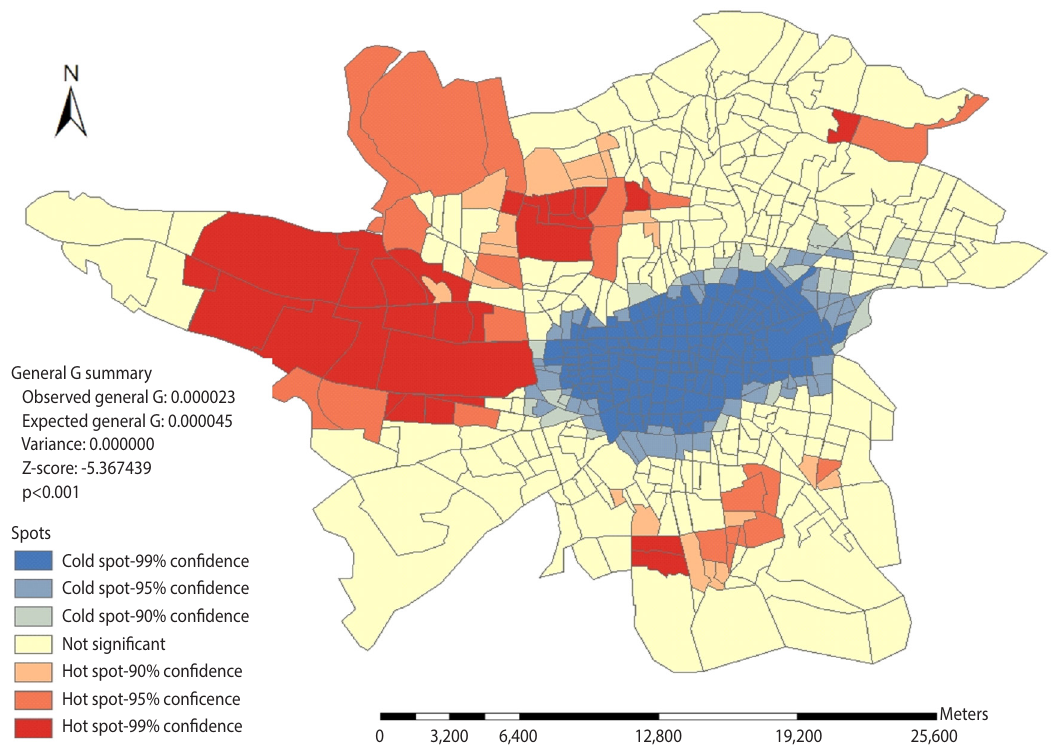
Figure 5. Spatial distribution of low and high spots regarding density of fatal traffic collisions based on traffic areas in Tehran during April 2014 to March